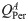
Evaluation of hypotheses about speech perception and adaptation in our modeling work.The model (Section 1 Model definition) enables to define different hypotheses about the sensory pathways involved in speech perception (Section 2 Formulation of speech production and perception questions) and the learning mechanisms involved in adaptation (Section 3 Adaptation hypotheses). Concerning speech perception, we evaluate hypotheses QPerA and QPerF, corresponding to the involvement of the auditory pathway only, or the fusion of somatosensory and auditory pathways. Concerning adaptation, we evaluate hypotheses HAdM, HAdΦ and HAdMΦ, corresponding respectively to an update of the auditor-motor internal model, an update of the auditory characterization of the perturbed phoneme, or both updates simultaneously. Combining hypotheses about perception and adaptation further enables to identify and test different scenarios simulating the experimental paradigm of Lametti et al. [1]. Scenarios leading to perceptual changes incompatible with those observed by Lametti et al. [1] are discarded (x-boxes, Section 4 Evaluation with respect to perception). The remaining scenarios (✓-boxes) are evaluated with respect to their predictions of compensation in production (Section 5 Evaluation with respect to production) and only those that are consistent with results of Lametti et al. [1] are kept. Finally, we evaluate the last scenarios with respect to correlations between perceptual boundary shift and compensation magnitude (Section 6 Evaluation with respect to correlations). The only scenario that matches the no-correlation observation of Lametti et al. [1] is gray-shaded.